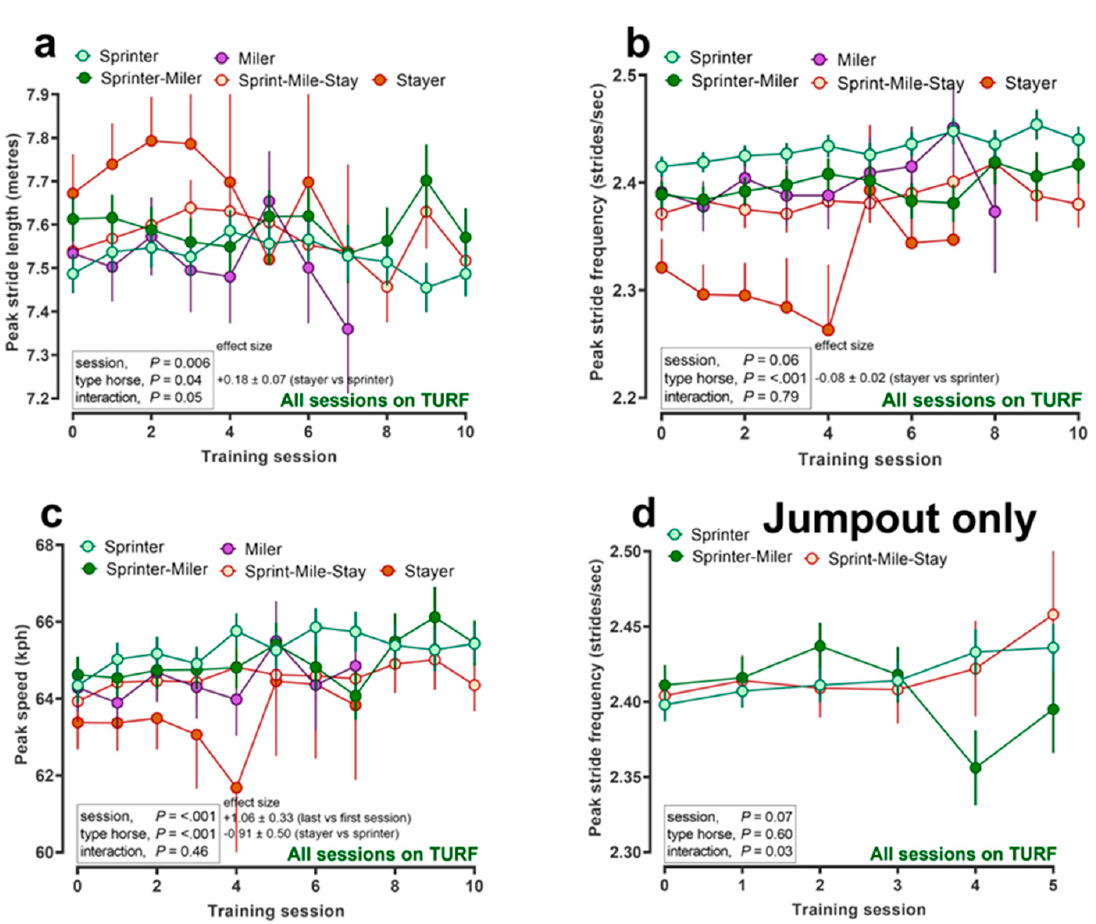
Figure 2. Evolution of locomotory parameters throughout the training season. Change in locomotory parameter with number of training sessions (‘session’) for each type of racehorse (‘type horse’). Racehorses were categorised based on competing in races of known distance, as described in Methods. ( a – d ) data are estimated marginal means ± SEM for consecutive training sessions (x-axis) over the course of two racing seasons, adjusting for age of racehorse and interval between training sessions. Individual racehorse, year/training month were included as random effects. Data were obtained using an appropriately fitted ‘Equimetre’ device from a single racing yard in Victoria, Australia.